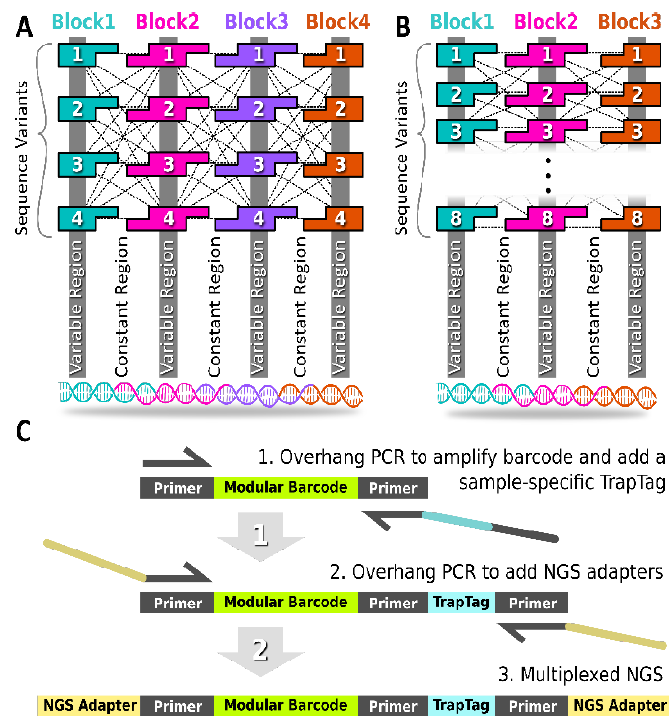
Figure 1. Modular Barcode Design. ( A ) The first-generation modular barcode library (gen_1) con- tained four blocks with single-stranded overhangs for mixing and annealing. For each block, four variants were obtained allowing the generation of 4 4 (256) barcode sequences. ( B ) The second-generation modular barcode library (gen_2) contained three blocks. The eight variants per block allowed for generation of 8 3 (512) sequences. ( C ) A UMI Trap Tag sequence was appended using overhang PCR to facilitate multiplex NGS sequencing of multiple samples in parallel. Table 1. Modular barcode library